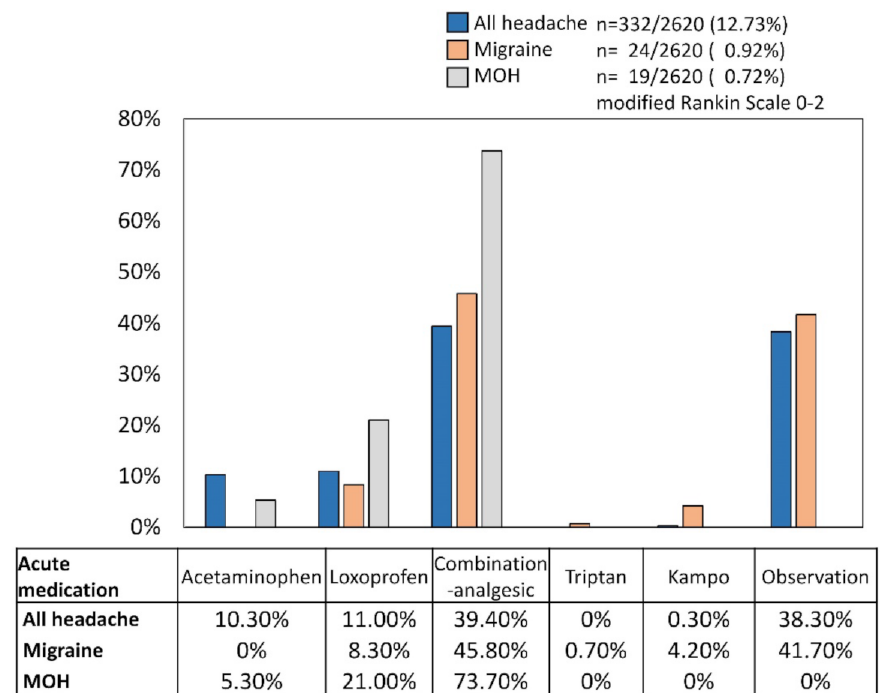
Figure 2. The proportion of acute medication use in all headache disorders, migraine, and medication overuse headache (MOH) respondents. The respondents all lived independently (modified Rankin Scale 0–2).